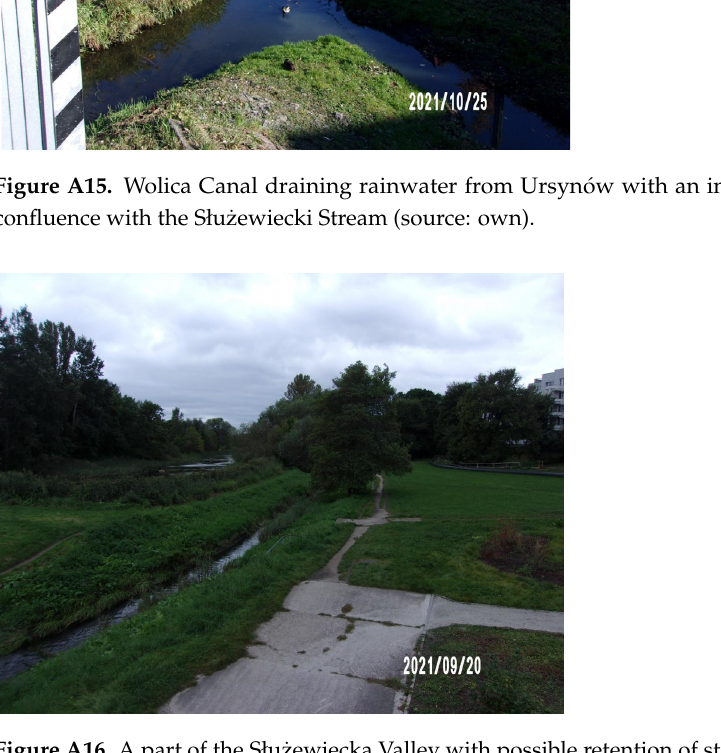
Figure A16. A part of the S ł u ż ewiecka Valley with possible retention of stormwater (source: own).